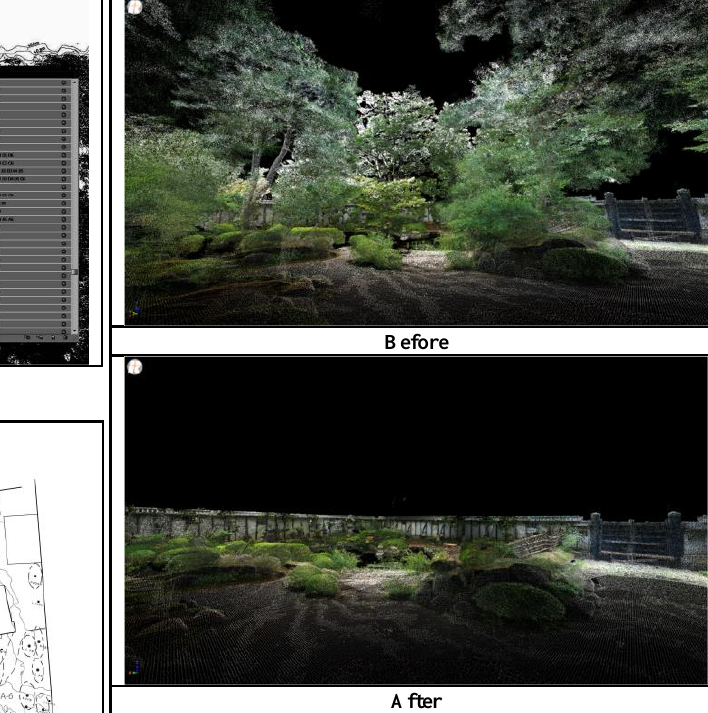
Figure 8. Drawing of contour line Figure 9. Ground Plan of Matsumoto Gokichi Old House